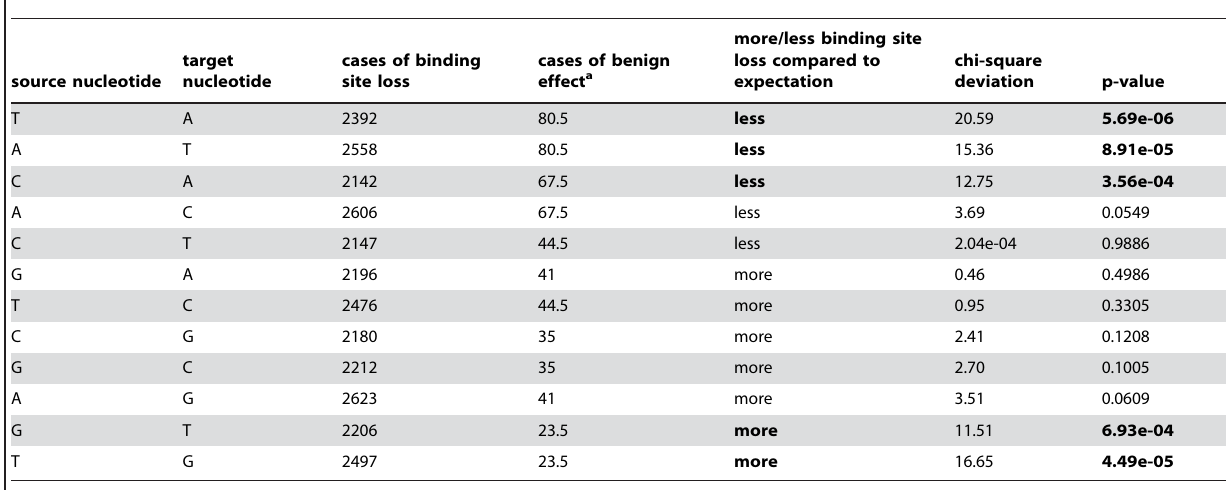
Table 2. Comparison of the distributions of substitution types among cases of binding site loss and those of benign effect.